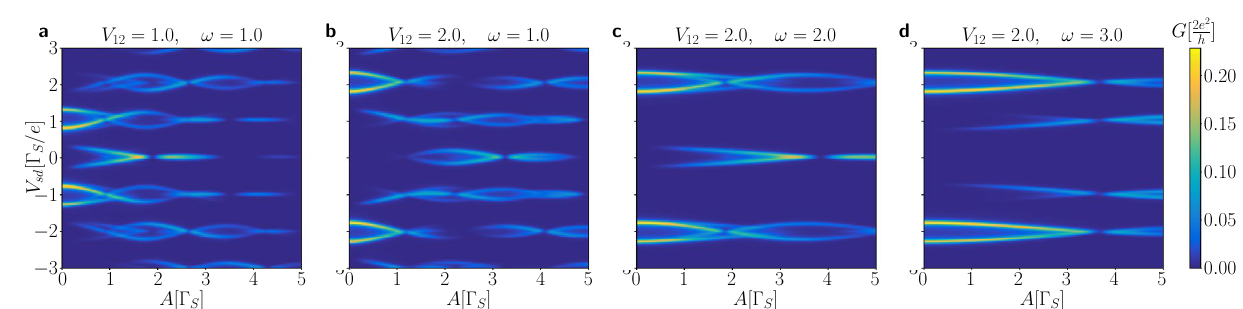
2 / h 0 , Ŵ 0.1 . N /Ŵ S = =